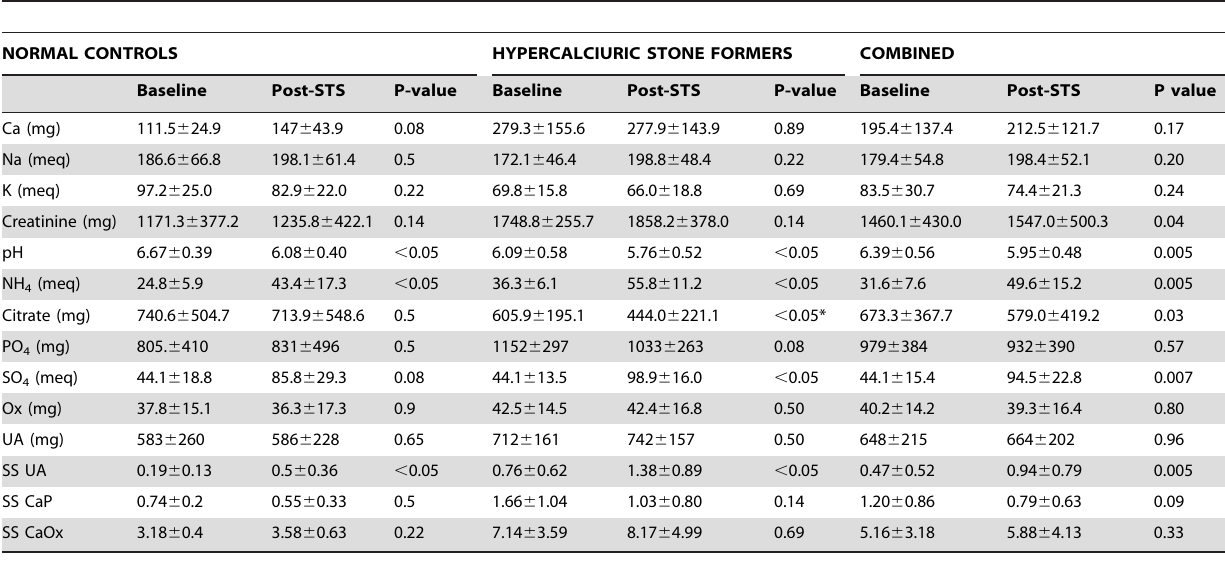
Table 1. Effects of STS on 24 hour urine chemistry in hypercalciuric calcium stone formers (n=5) compared to its effects in normal patients (n =5), and the 2 groups combined (n=10); mean 6 SD.